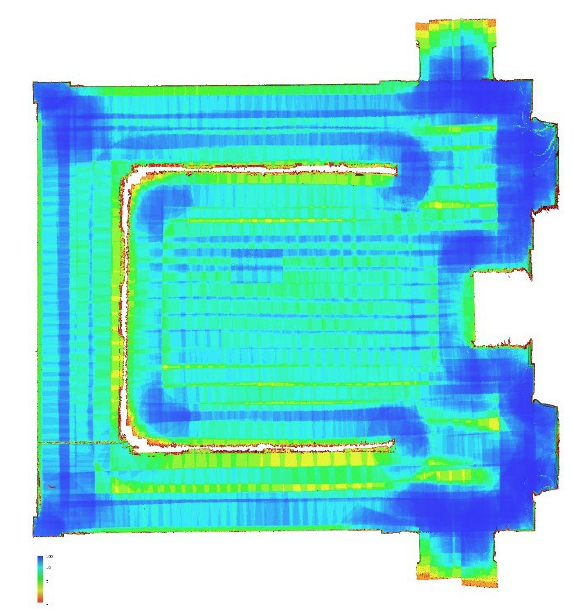
Figure 8. statistical analysis of the photogrammetric model of the survey: the dense point-cloud confidence, with values between 1 (red) and 100